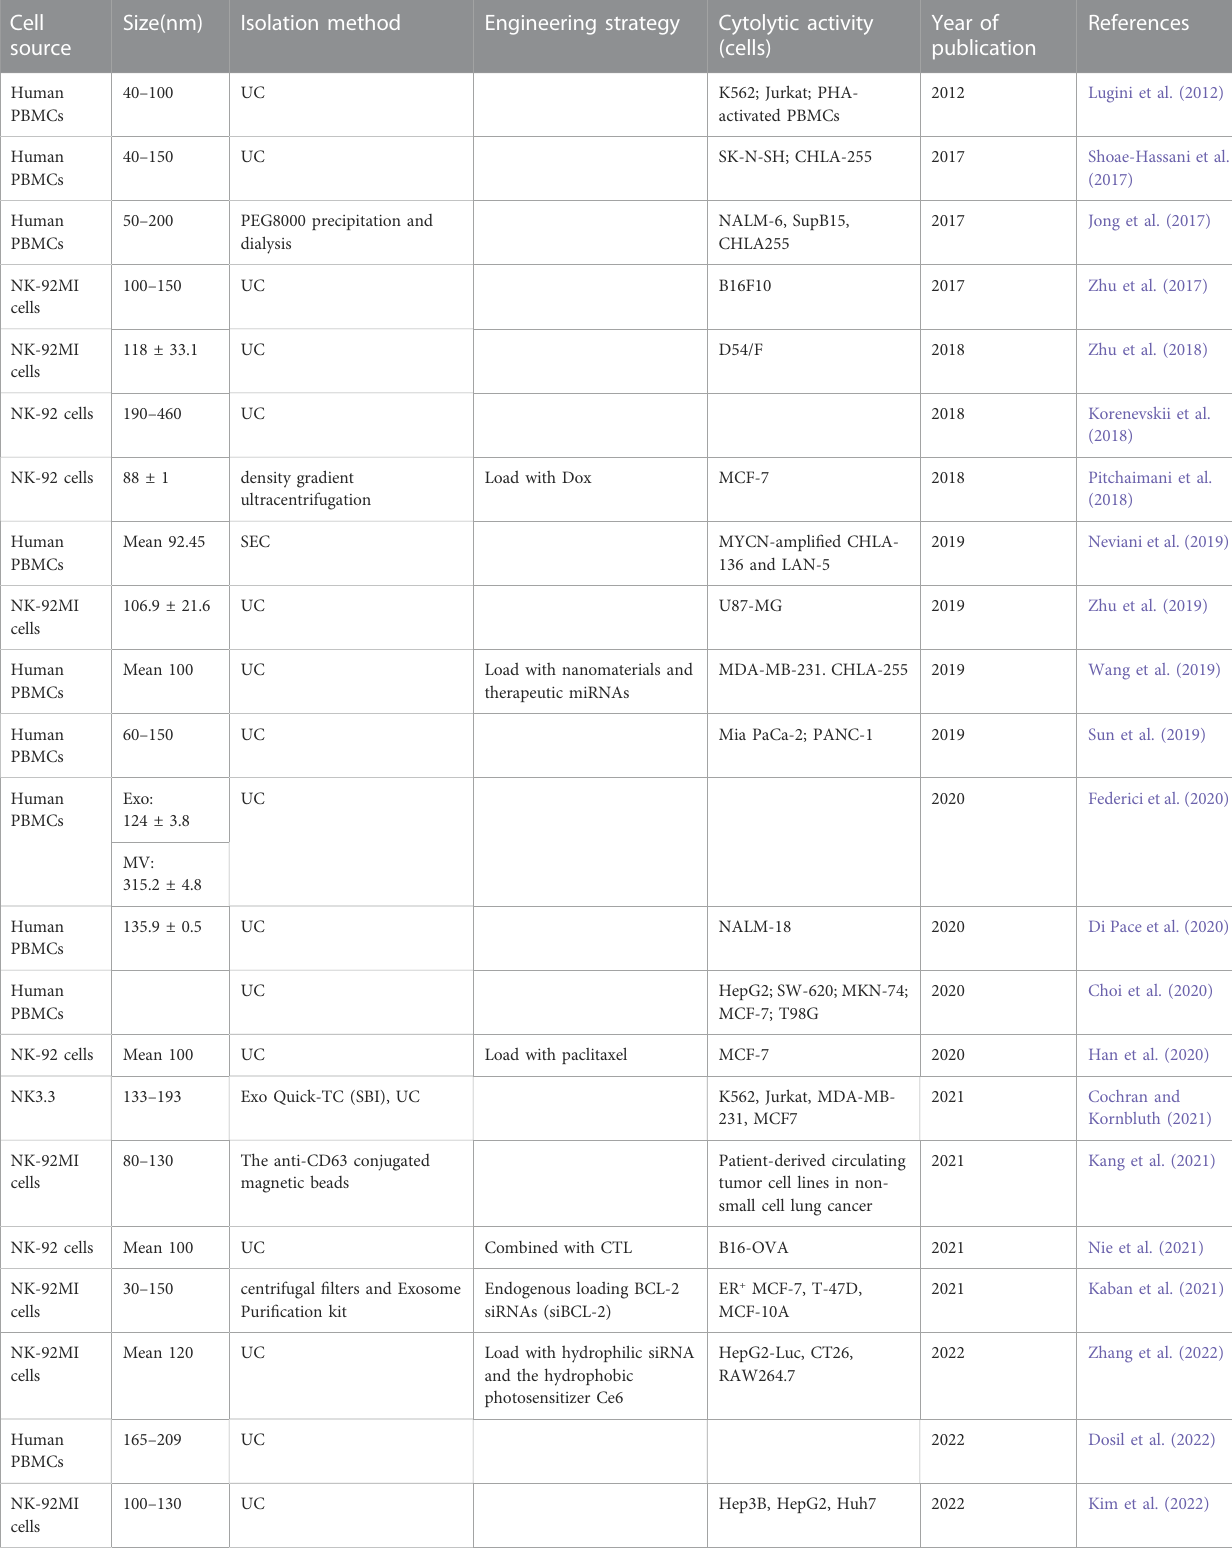
TABLE 3 Existing studies for